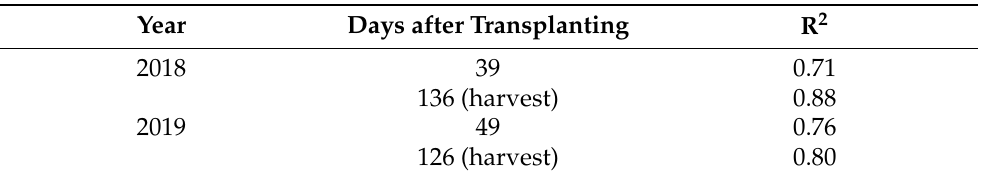
Table 3. Coefficient of determination (R 2 ) for the linear correlation between NBI and single-year cabbage yield at two growing